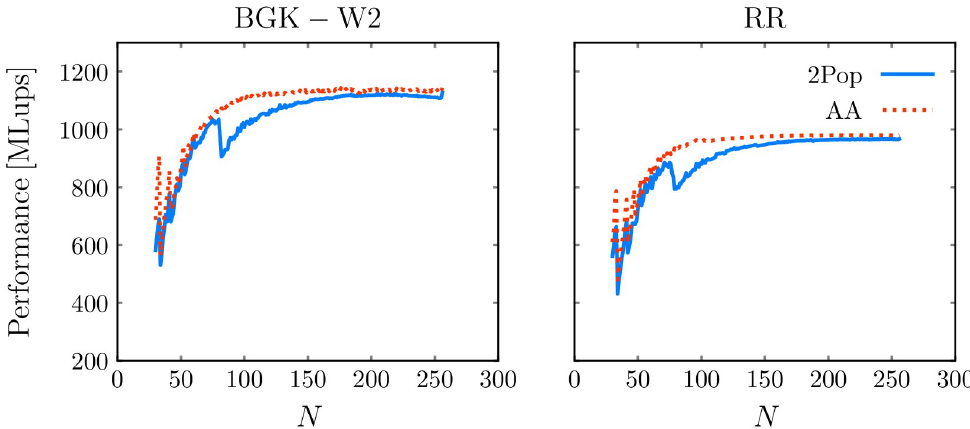
Fig 7. Dependence of domain size on performance on GPU. Left: BGK-W2; Right: RR. Simulations are run on an RTX 2080 Ti GPU.